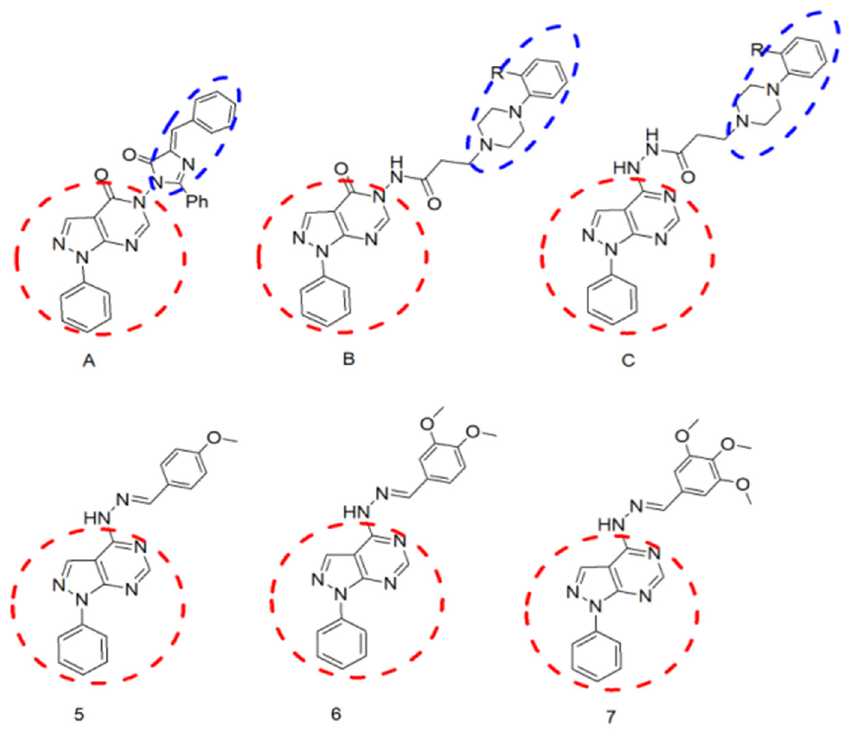
Figure 1. Chemical structure of previously reported compounds ( A – C ) [10] as a scaffold for the design of the newly synthesized compounds ( 5 – 7 ).